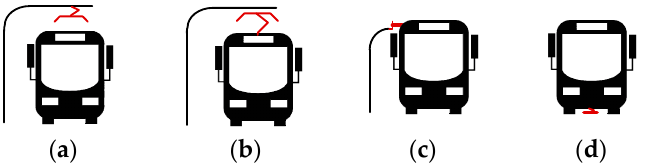
Figure 3. Different types of pantographs: ( a ) downward; ( b ) upward; ( c ) horizontal; ( d ) underbody.